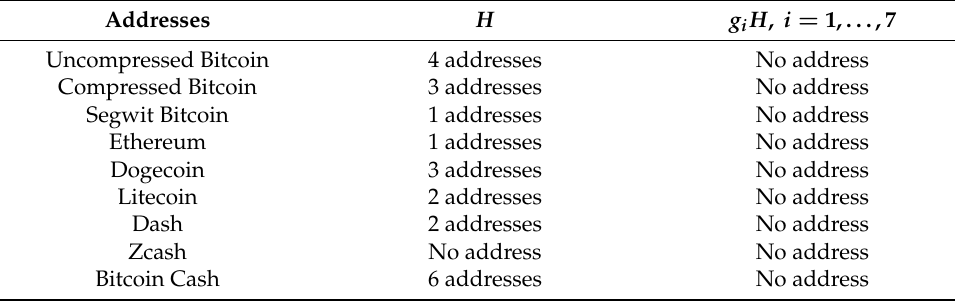
Table 2. Results of the subsets